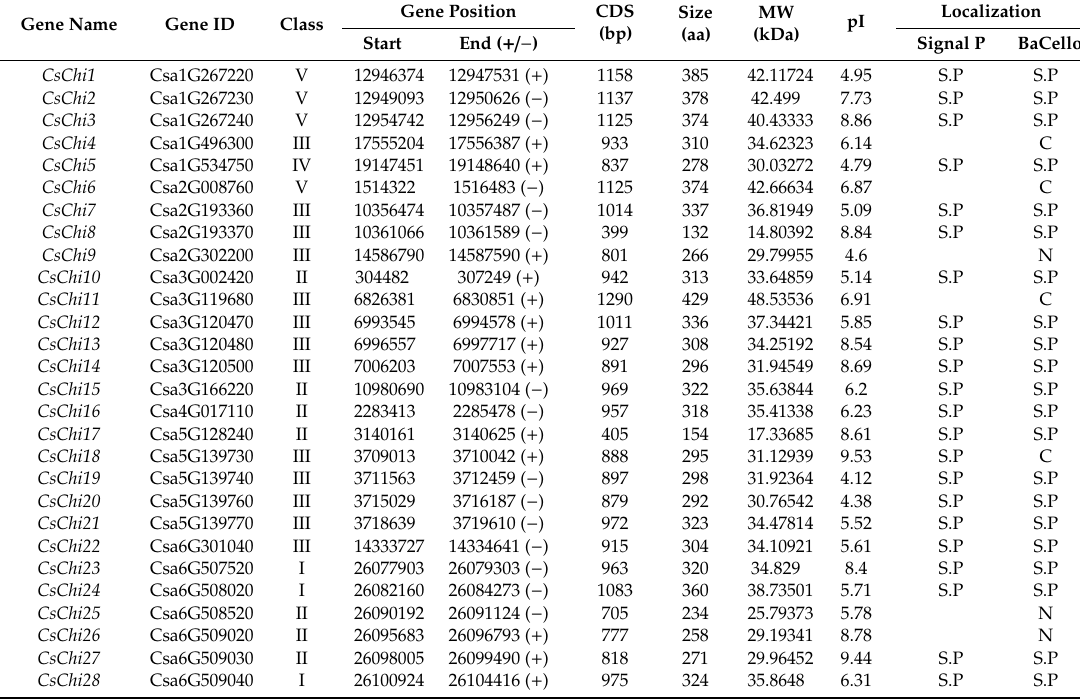
Table 1. Detailed information about 28 predicted cucumber chitinase